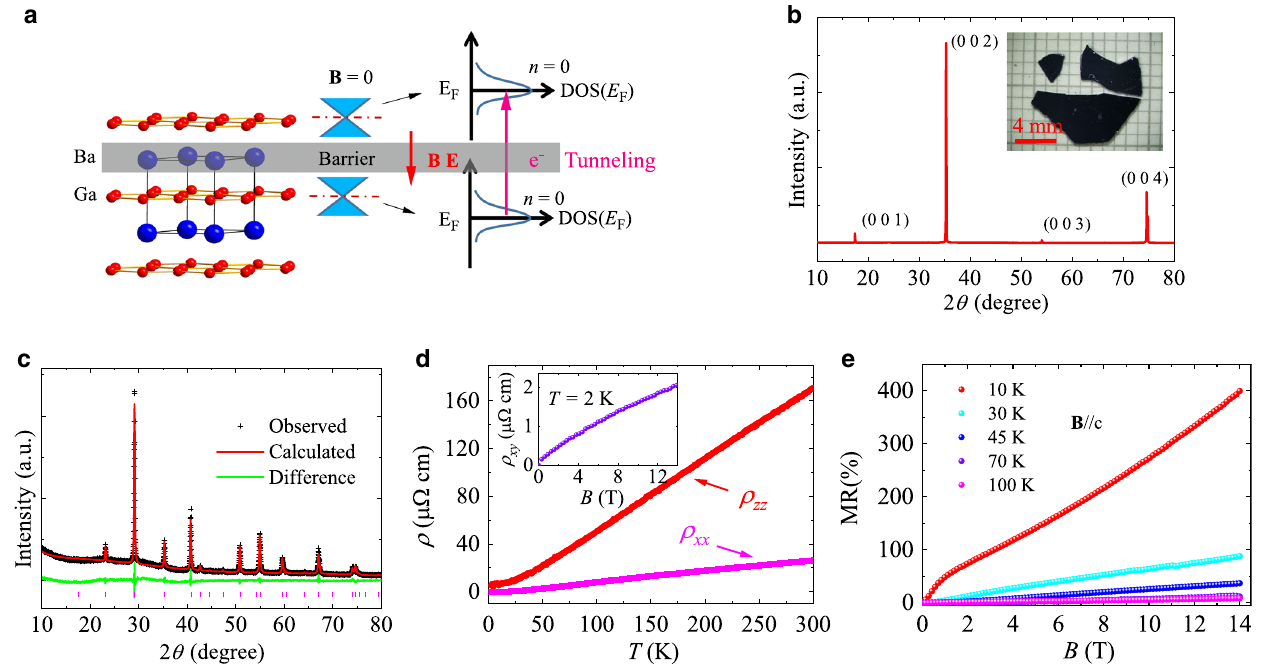
Fig. 1 Crystal structure and in-plane transport properties of BaGa 2 . a Crystal structure and schematic of the interlayer tunneling of zeroth LLs ’ s Dirac fermions of BaGa 2 . The red and blue balls represent Ga and Ba atoms, respectively. b Single crystal X-ray diffraction pattern. Inset: the picture of BaGa 2 crystal. c Powder X-ray diffraction pattern with re fi ned lattice parameters a = 4.43 Å and c = 5.08 Å (SG: P6/mmm). d Temperature dependence of in- plane ρ xx (T) and interlayer ρ zz (T). Inset: fi eld dependence of Hall resistivity ρ xy at 2 K. e In-plane MR at different